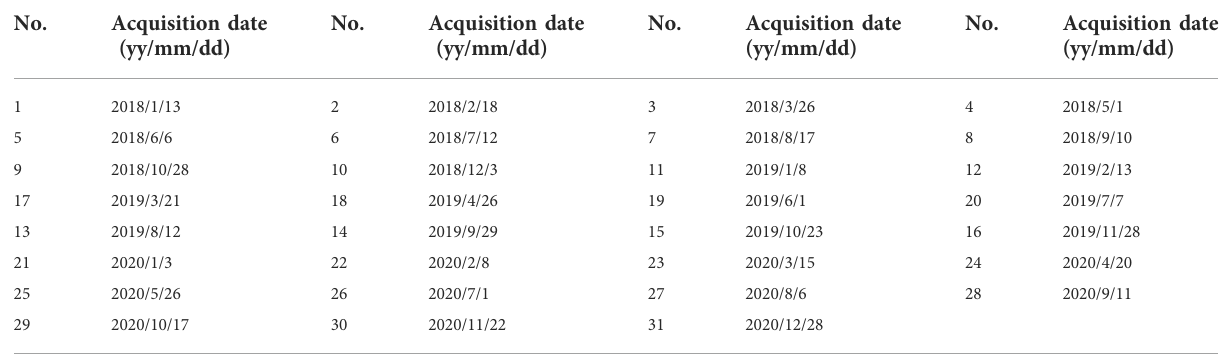
TABLE 3 SAR data acquisition dates in this